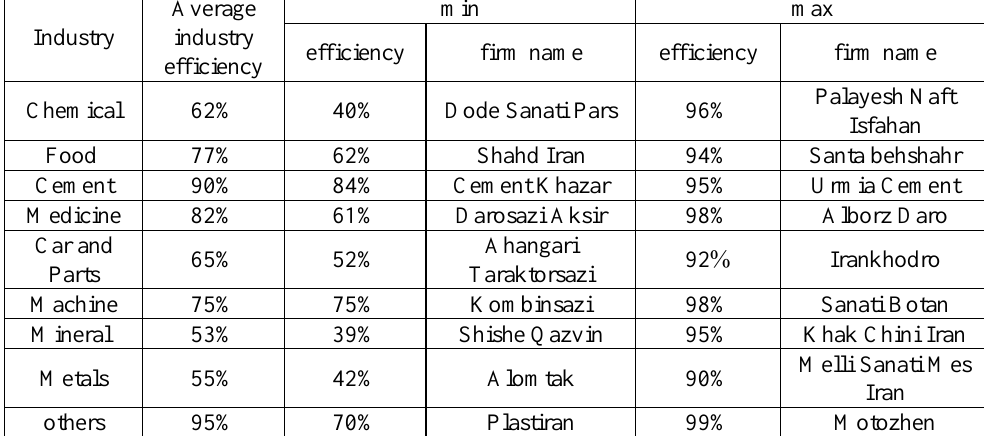
Table 2. The efficiency of different